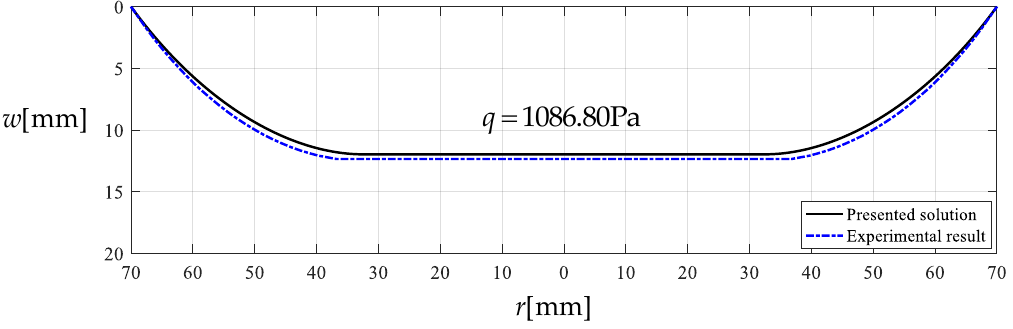
Figure 5. Deflection profiles for q = 1086.80 Pa, drawn by experimental data and analytical solution. To further prove the e ff ectiveness of the closed-form solution presented in Section 3, a numerical analysis is conducted as follows. Suppose that we continue adopting all the conditions of this experiment example except for the spring sti ff ness coe ffi cient k , i.e., the elastic modulus E = 3.01 × 10 6 Pa, Poisson’s ratio ν = 0.45, thickness h = 0.3 mm, and radius a = 70 mm. The transverse uniformly distributed loads (the wind pressure value per unit area) still takes q = 1086.80 Pa; the springs still take uncompressed original length L = 43.05 mm and initial compressed length ∆ l = 0.05 mm; while the − 10 spring sti ff ness coe ffi cient k takes 10 N / mm, 1 N / mm, 0.3734 N / mm and 1 × 10 N / mm, respectively. Figure 6 shows the deflection profiles of this circular polymer thin film, where the solid lines represent the results theoretically calculated by the closed-form solution presented in this paper, the dash-dotted line represents the experimental results, and the dashed line represents the results theoretically calculated by the well-known Hencky solution for non-contact issues. It can be seen from Figure 6 that the horizontal segment of the solid lines becomes shorter and shorter as the sti ff ness coe ffi cient k of − 10 springs decreases, until k takes 1 × 10 N / mm the horizontal segment becomes invisible to the naked eye. This shows that the contact area between the circular polymer thin film and the movable circular electrode plate of the parallel plate capacitor becomes smaller and smaller as the sti ff ness coe ffi cient k − 10 of springs decreases, until k takes 1 × 10 N / mm the contact area almost vanishes, i.e., when k takes − 10 1 × 10 N / mm the contact problem here almost becomes a non-contact issue. From Figure 6 it can be clearly seen that the solid line drawn by the closed-form solution obtained in Section 3 are very close to the dashed line drawn by the well-known Hencky solution for non-contact issues. This indicates that the closed-form solution presented here is reliable, as far as the recognized e ff ectiveness of the well-known Hencky solution is